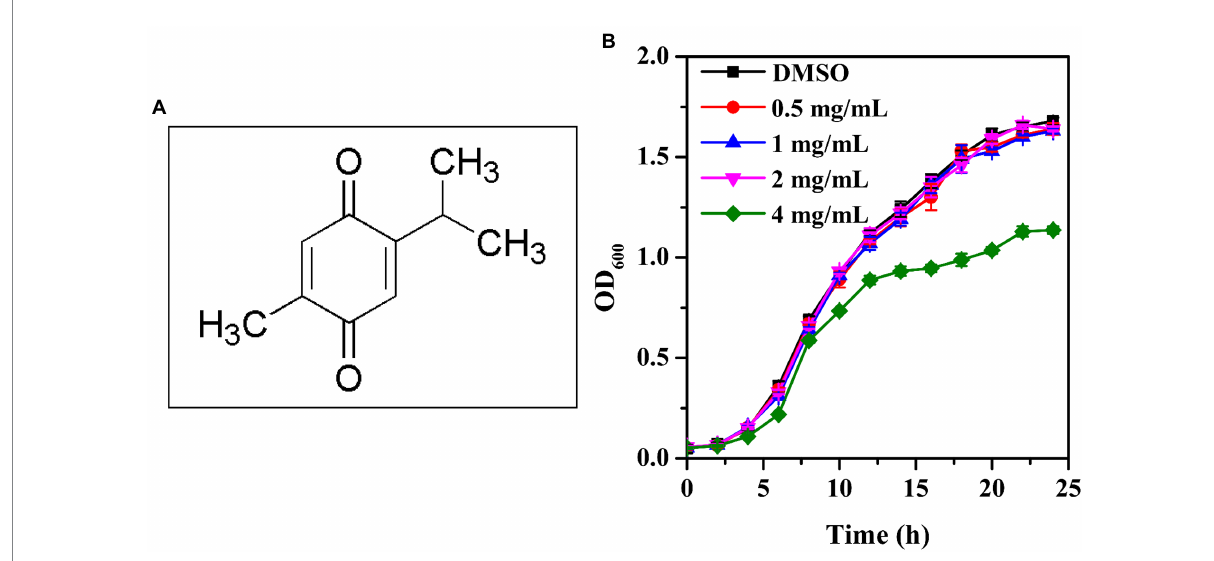
FIGURE 1 Chemical structure of thymoquinone (A) and growth profile of P. aeruginosa PAO1 following exposure to 0.5, 1, 2, and 4 mg/ml of thymoquinone for 24 h (B) . DMSO served as the negative control. Error bars represent standard deviations of three measurements.